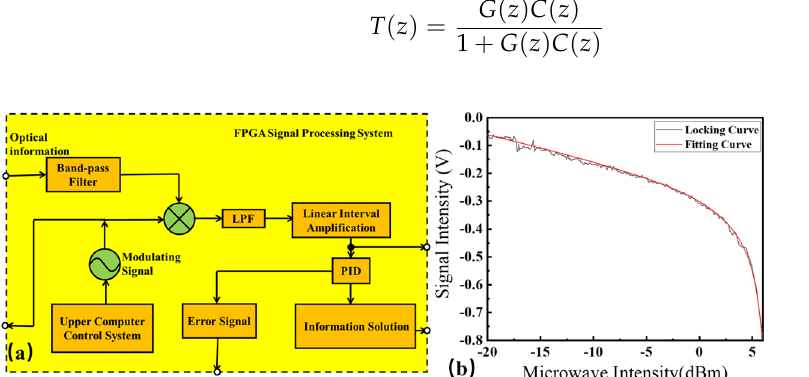
Figure 4. ( a ) Structure diagram of FPGA information processing system. ( b ) Microwave intensity locking curve and its fitting